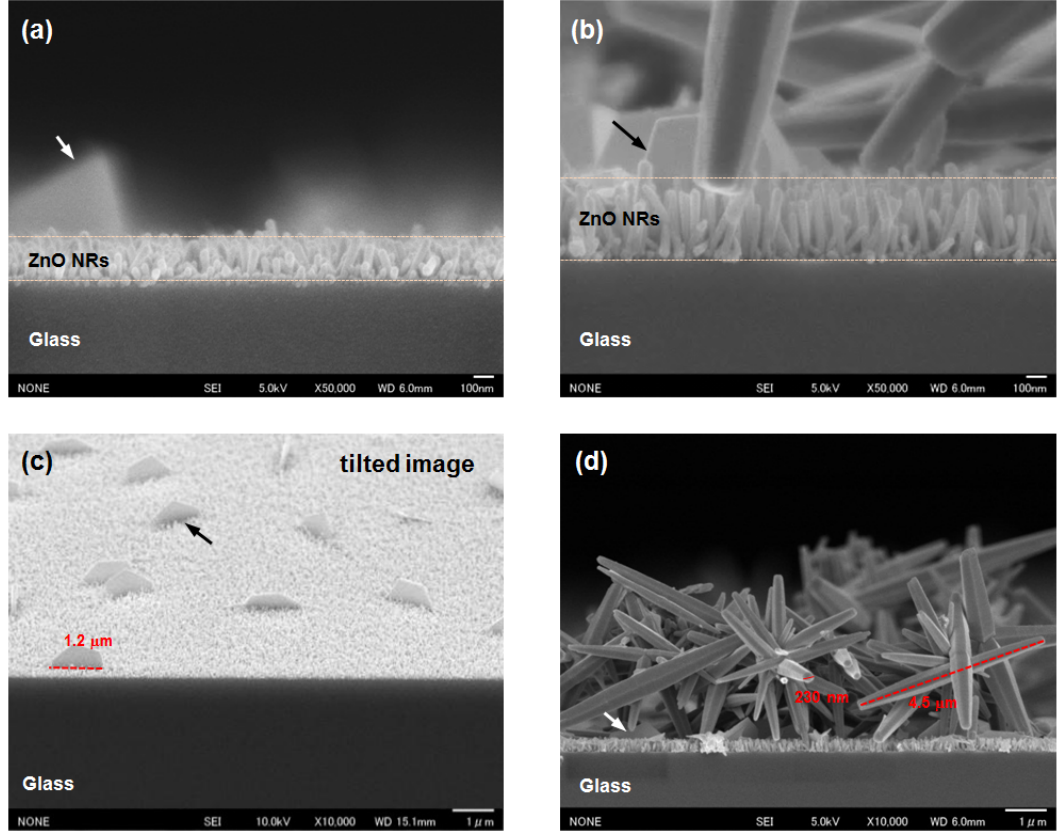
Figure 3. FESEM images of ZnO NRs grown on ( a , c ) 20 nm-thick and ( b , d ) 50 nm-thick AZO seed layers annealed at 150 °C; ( a , b ) under high magnification and ( c , d ) under low magnification. Arrows indicate plate-like ZnO